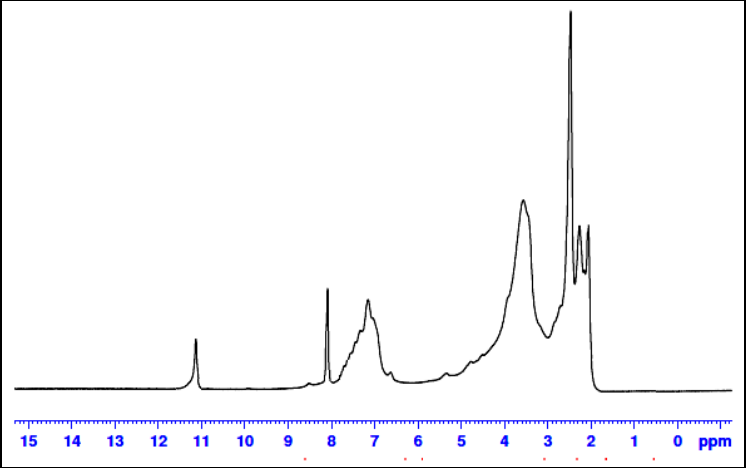
Figure 1 1 H NMR spectrum of compound A.